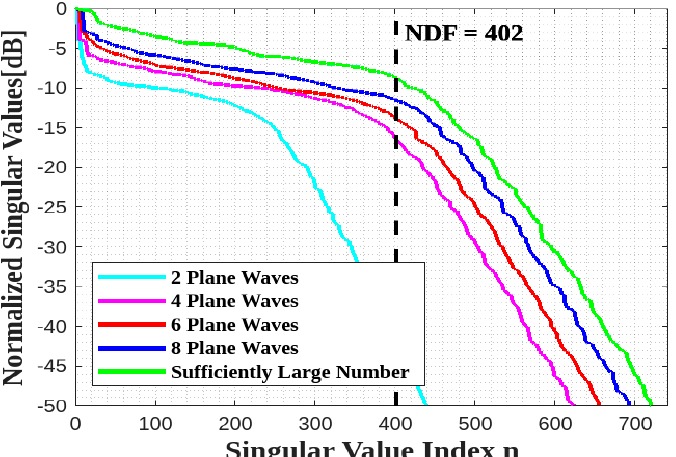
Figure 13. Comparison of the behavior of the normalized singular values for different numbers of impinging plane waves for two parallel XY faces.